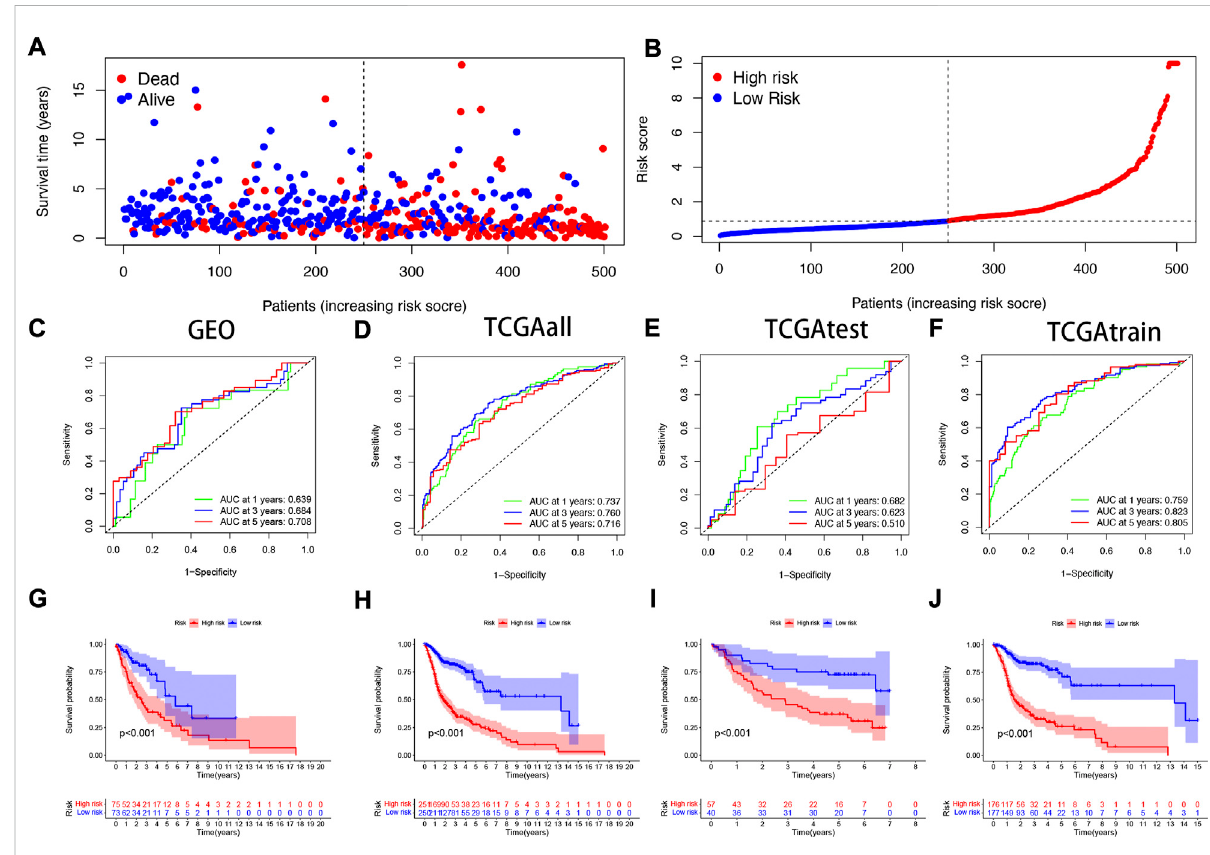
FIGURE 3 Validating the accuracy of the NFRGs model to predict patient prognosis (A,B) Partial likelihood deviation map. Time-dependent ROC curve of HNSCC patients (C) in the GEO cohort; (D) in the TCGA all cohort; (E) in the TCGA test cohort; (F) in the TCGA train cohort. K-M survival curve of HNSCC patients (G) in the GEO cohort; (H) in the TCGA all cohort; (I) in the TCGA test cohort; (J) in the TCGA train